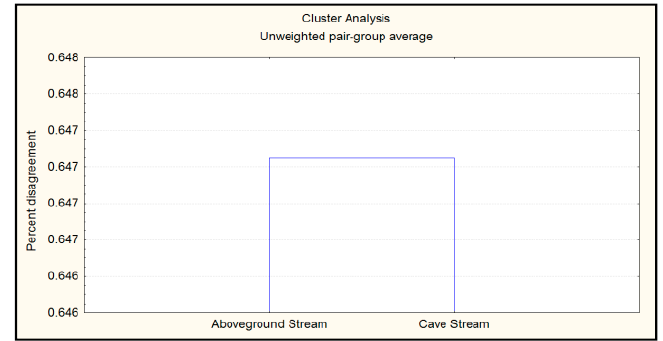
Figure 3. Phytoplankton cluster analysis.